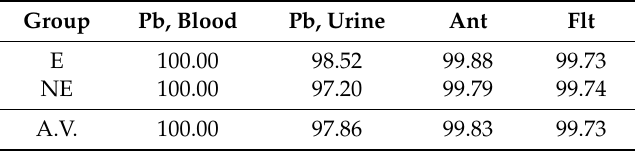
Table 13. Ratio (%) between the estimated contaminant concentration in blood or urine due to the diet route only and total concentration measured in the HBM study. E = exposed, NE = non